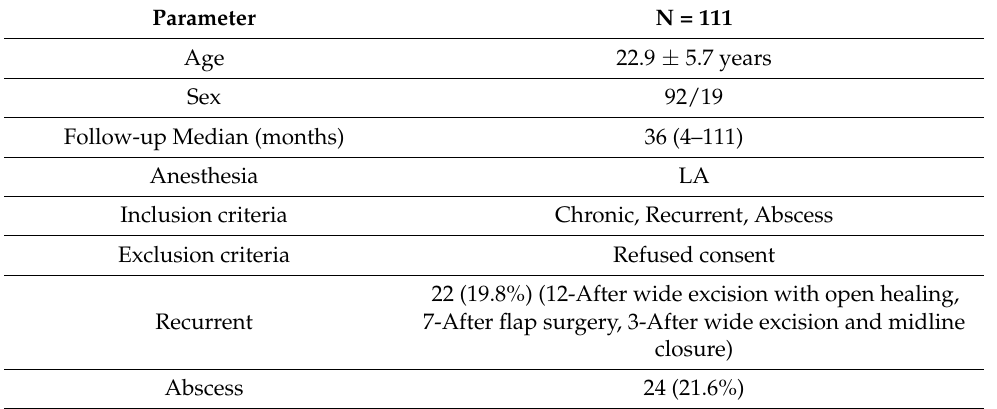
Table 1. Demographic data & patient